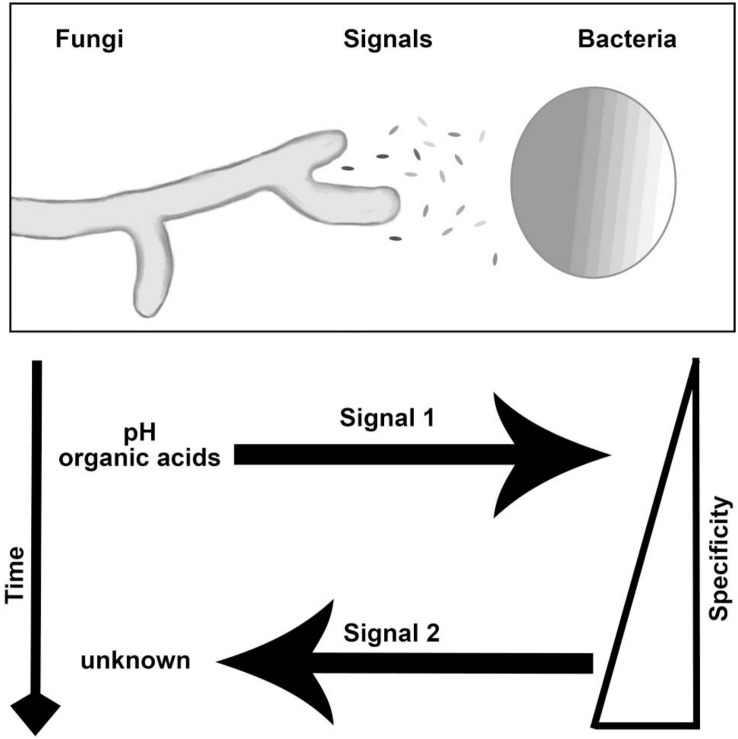
Interaction and signaling model for M. elongata and Burkholderia. The nature, timing, specificity, and direction of signals are indicated in the lower panel. Findings included within show that there are at least two ordered signals exchanged, first involving the secretion and utilization of fungal organic acids by bacteria and second the secretion of an undescribed factor by Burkholderia which stimulated fungal growth. Specificity refers to the ability of close relatives to induce similar morphological shifts, see Tables 2, 3 for more details.